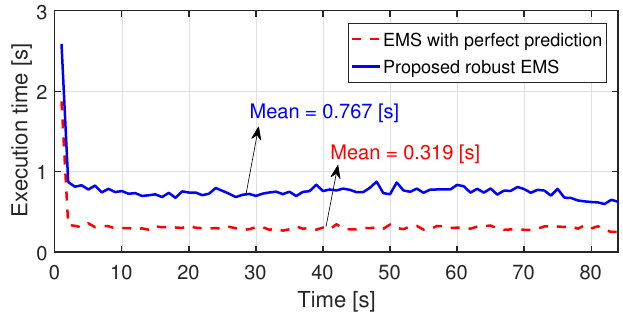
Figure 5. Computational time of the proposed EMS (blue solid line) and the EMS with perfect predictions (red dashed